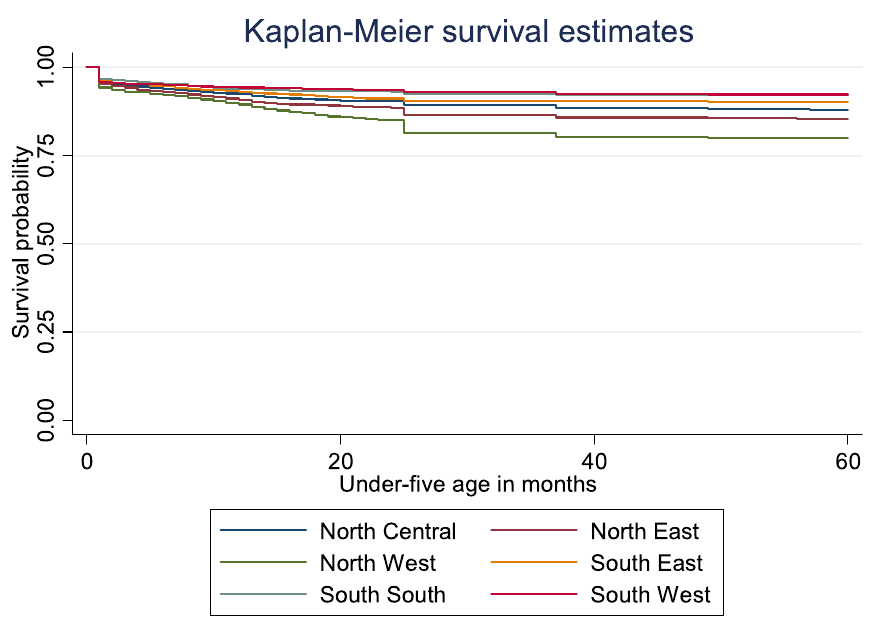
Figure 4. Plot of the Kaplan–Meier survival estimates of under-five mortality by geopolitical zones in Nigeria,